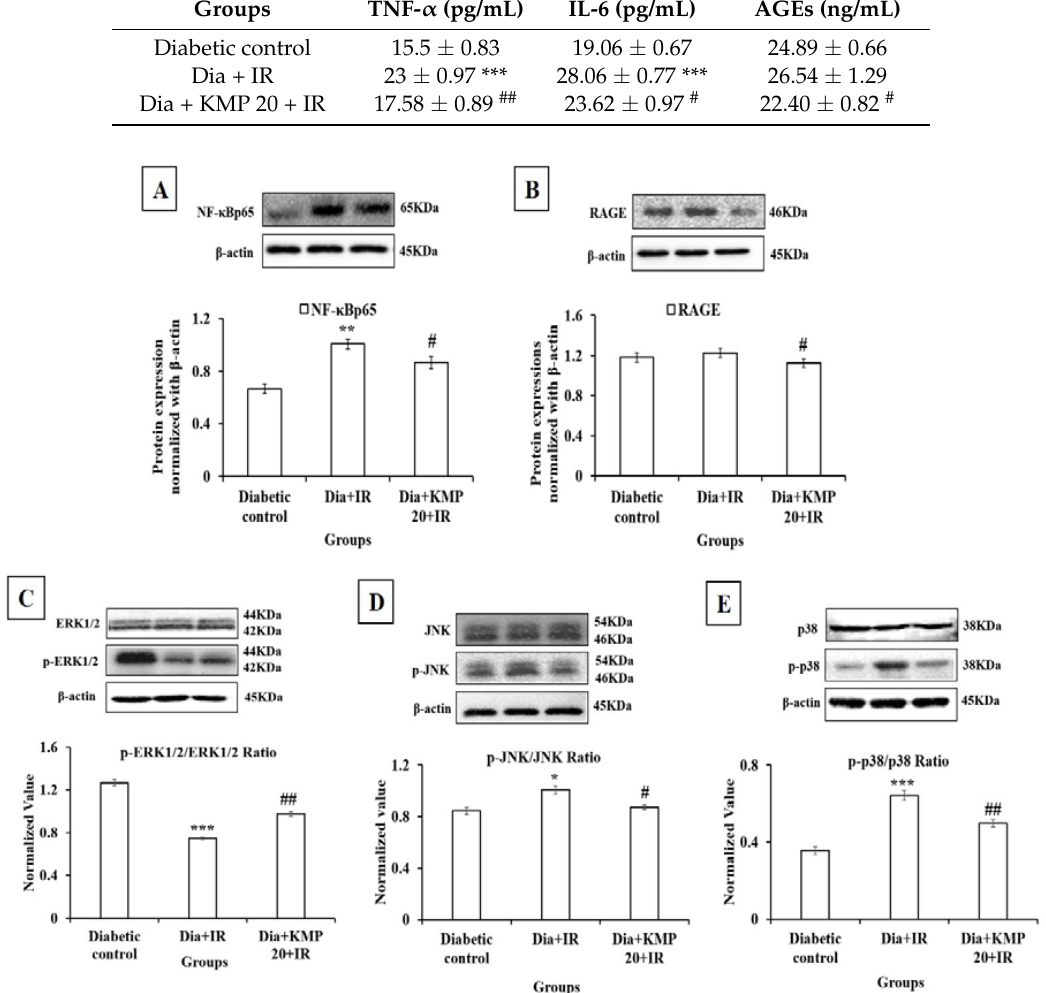
Figure 3. Effect of kaempferol on ( A ) NF- κBp65; ( B ) RAGE; ( C ) ERK1/2, p-ERK1/2; ( D ) JNK, p-JNK; ( E ) p38, p- p38. Protein expressions are normalized with β -actin. All the values are expressed as mean ± S.E.M.; n = 3 in each group. * p < 0.05; ** p < 0.01, *** p < 0.001 vs. diabetic control; # p < 0.05; ## p < 0.01 vs. Dia + IR.